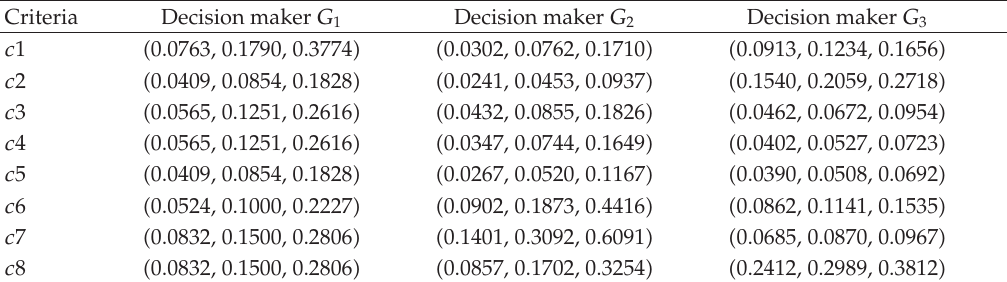
Table 7: Computed global weights for